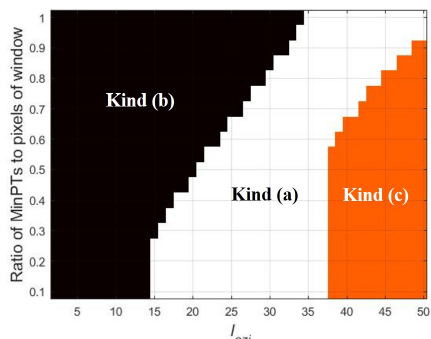
Figure 16. Clustering accuracy of real target signature with different l azi and R Minpts . Black part denotes the real target signatures are classified as different clusters (kind (b)). The orange part denotes the real and false target signatures are classified as one cluster (kind (c)). The white part means real target signatures are classified as one cluster (kind (a)).